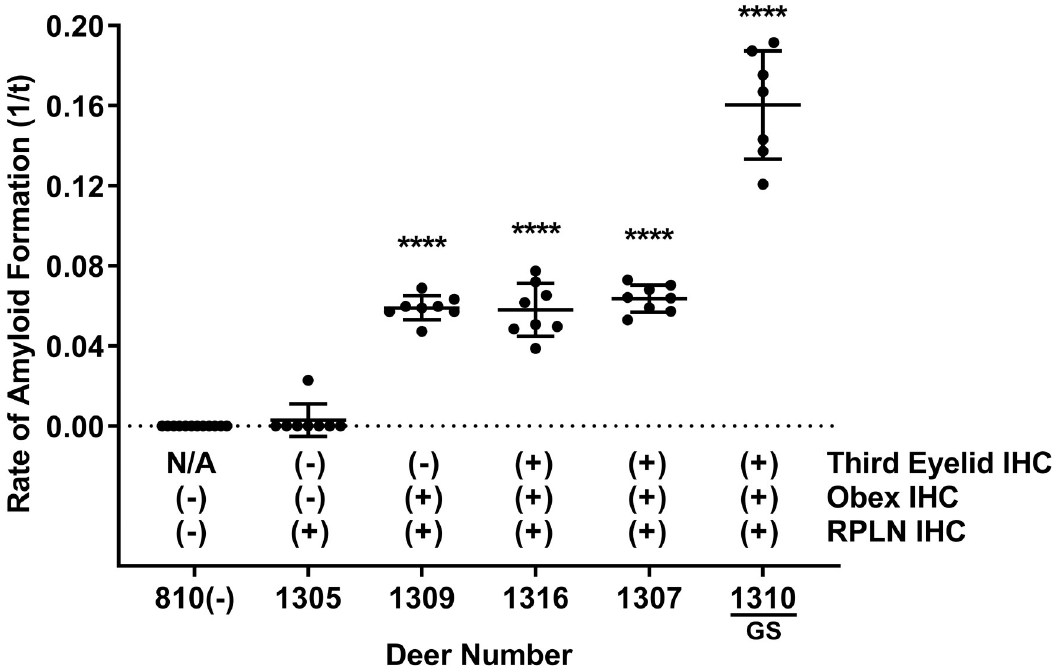
Fig 4. Detection of PrP CWD in pre-symptomatic deer by RT-QuIC and IHC. RT-QuIC analysis of third eyelid samples from four 96GG deer and one 96GS deer demonstrated significant amyloid seeding activity in 4 of 5 animals (80%) ( ���� p < 0.0001, two-tailed Mann-Whitney test) when compared with respective negative control tissues, while only 3 of 5 (60%) were positive by IHC. RT-QuIC detection of PrP CWD was comparable with IHC in retropharyngeal lymph node and obex samples tested. Data are presented as PrP CWD positive or negative by tissue type and detection method. Each third eyelid sample is represented by the mean and standard deviation from at least eight replicates. Abbreviations: RPLN, retropharyngeal lymph node, IHC; immunohistochemistry.